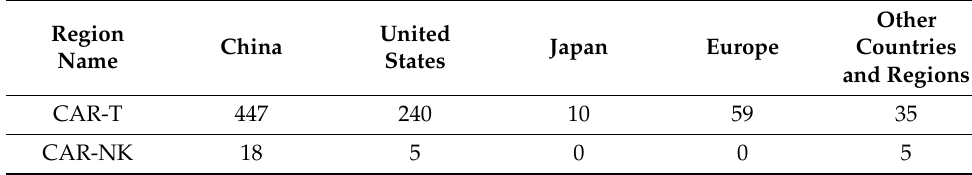
Table 2. Number of CAR-therapy clinical trials worldwide. Region Name